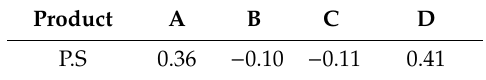
Table 4. Product satisfaction in the South Korean subcompact SUV